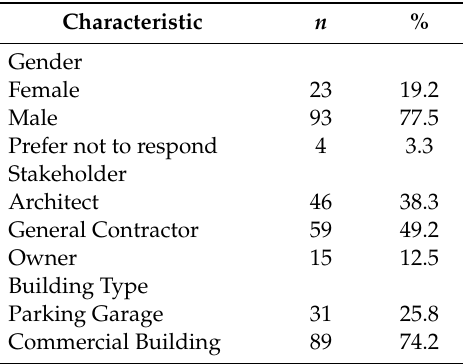
Table 1. Demographic Characteristics (n =